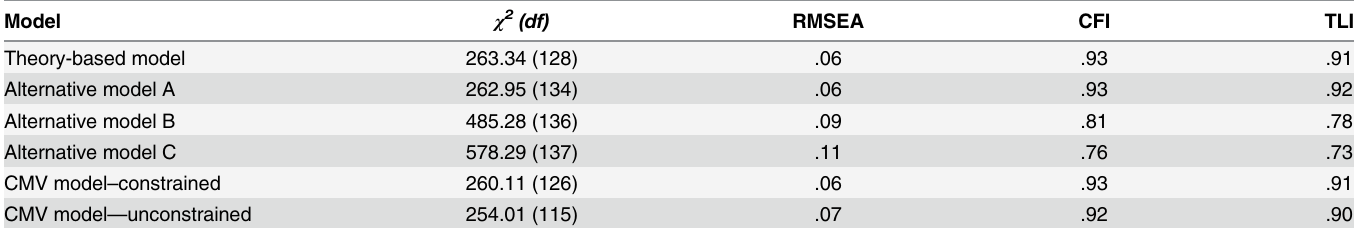
Table 1. Results from confirmatory factor analyses in study